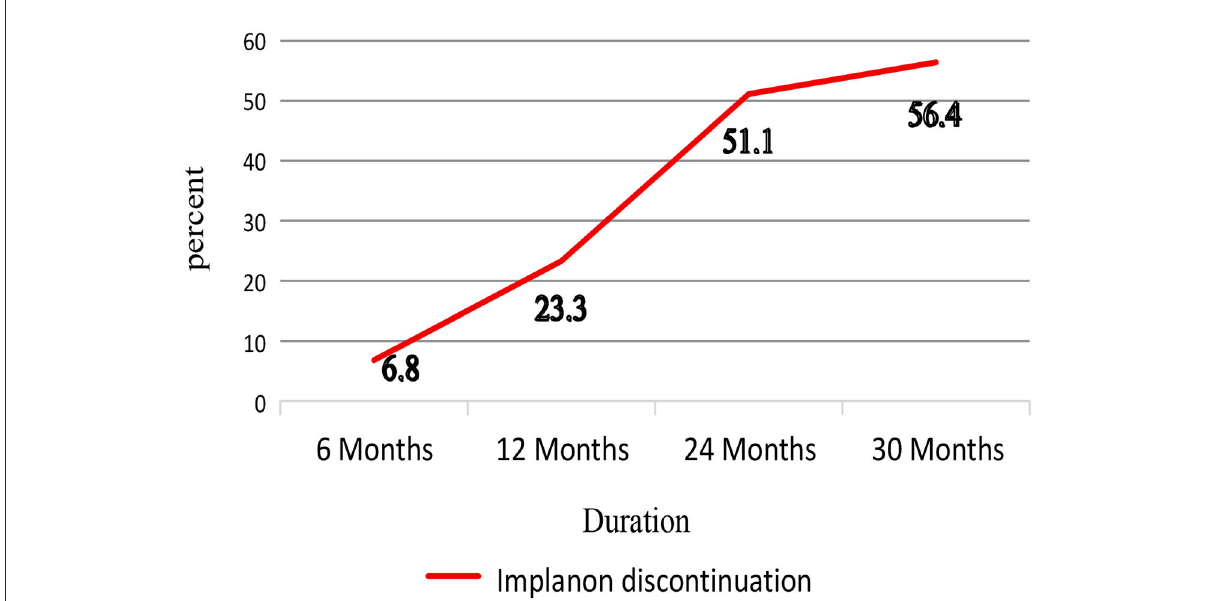
FIGURE2 Magnitude of early Implanon discontinuation among implanon users women visiting public health facilities to discontinue Implanon in Kembata Tambaro zone, South Ethiopia, 2020 ( n = 438).